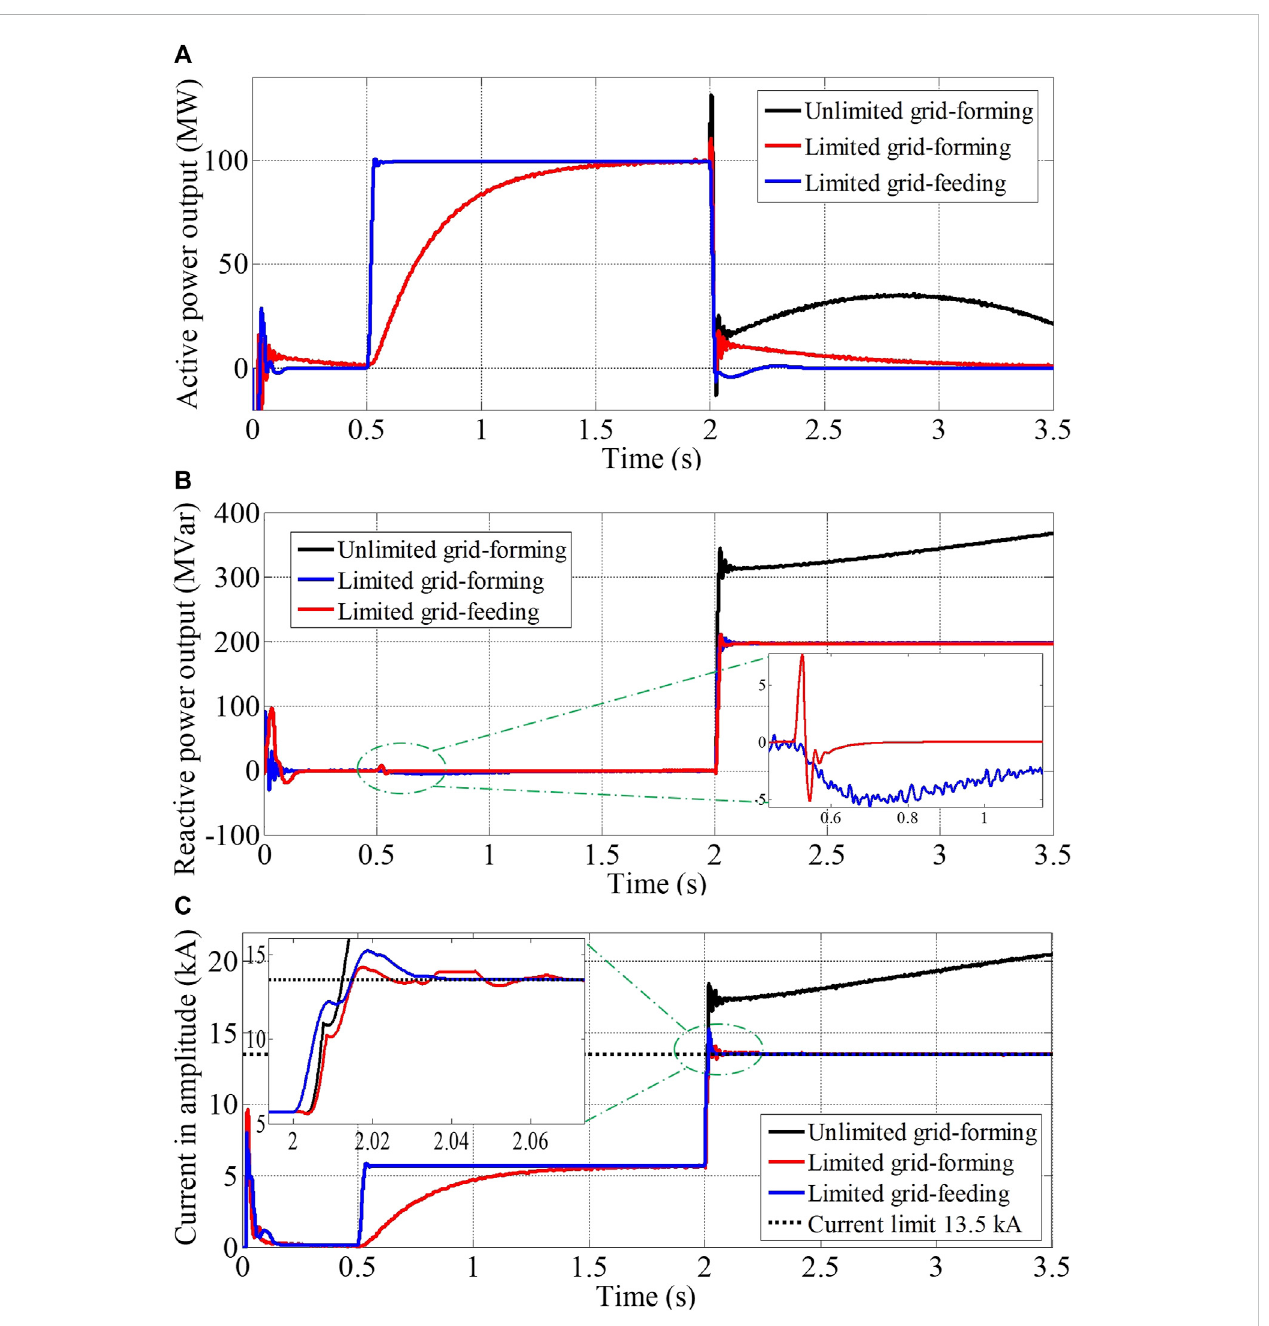
FIGURE 4 Open-loop Comparative Results. (A) Active power; (B) Reactive power; (C) Current in amplitude.